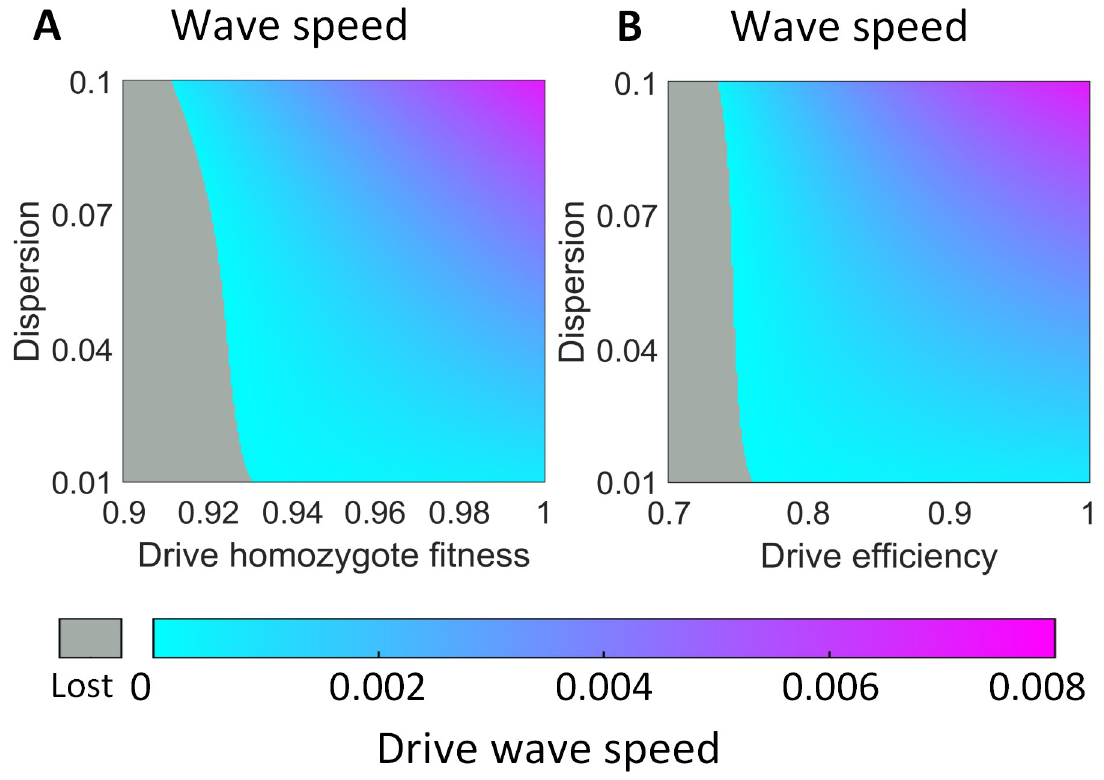
Fig 4. Drive wave speed. The drive wave advance speed is displayed (in unitless distance units per generation) as a function of dispersion and either A : drive fitness or B : drive efficiency. Gray indicates that a drive wave is not able to form.